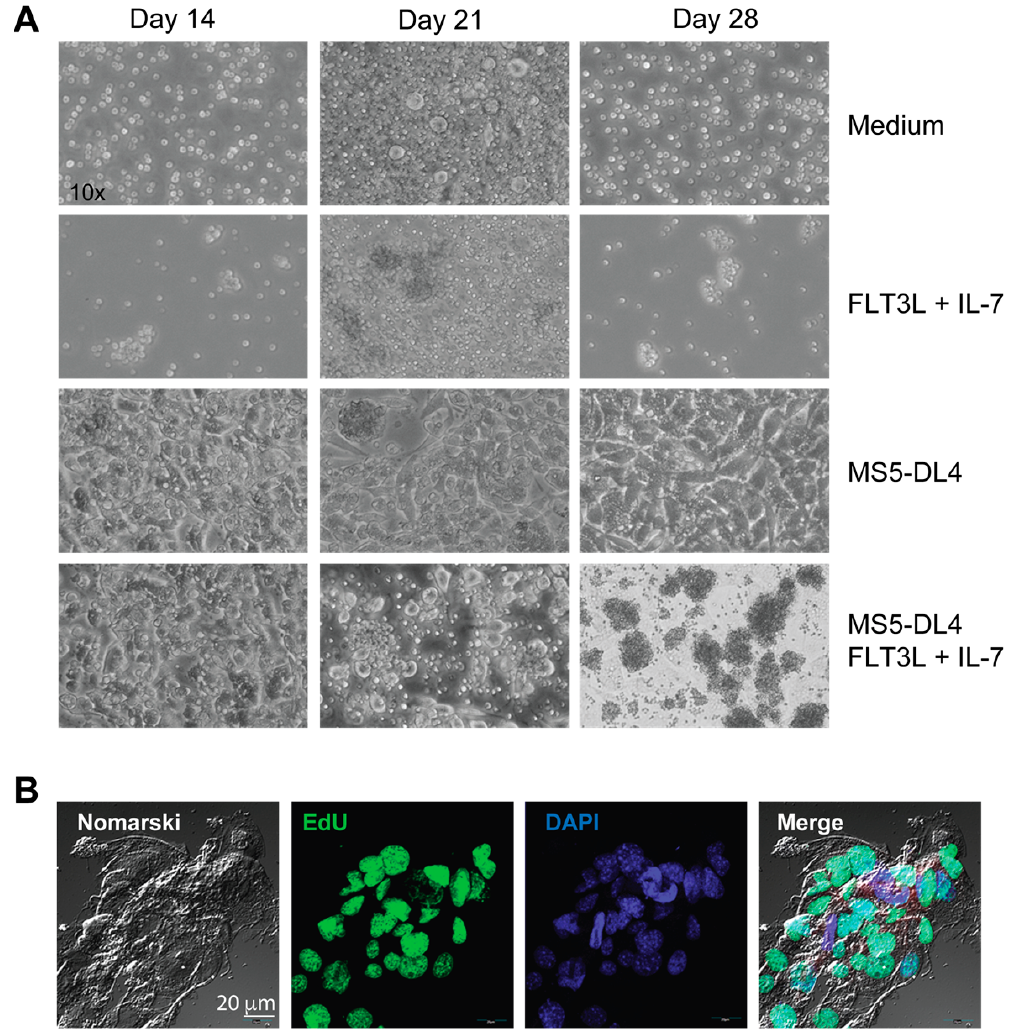
Figure 7. Leukemic cells maintained on MS5-DL4 cells require additional growth signals for expan- sion. ( A ) Phase contrast images of lymph node cells from NOD. Scid.Il15 − / − mice under the indicated growth conditions. ( B ) Proliferation of leukemic cells co-cultured with irradiated MS5-DL4 cells in the presence of FLT3 ligand (FLT3L) and IL-7 was assessed by EdU staining on day